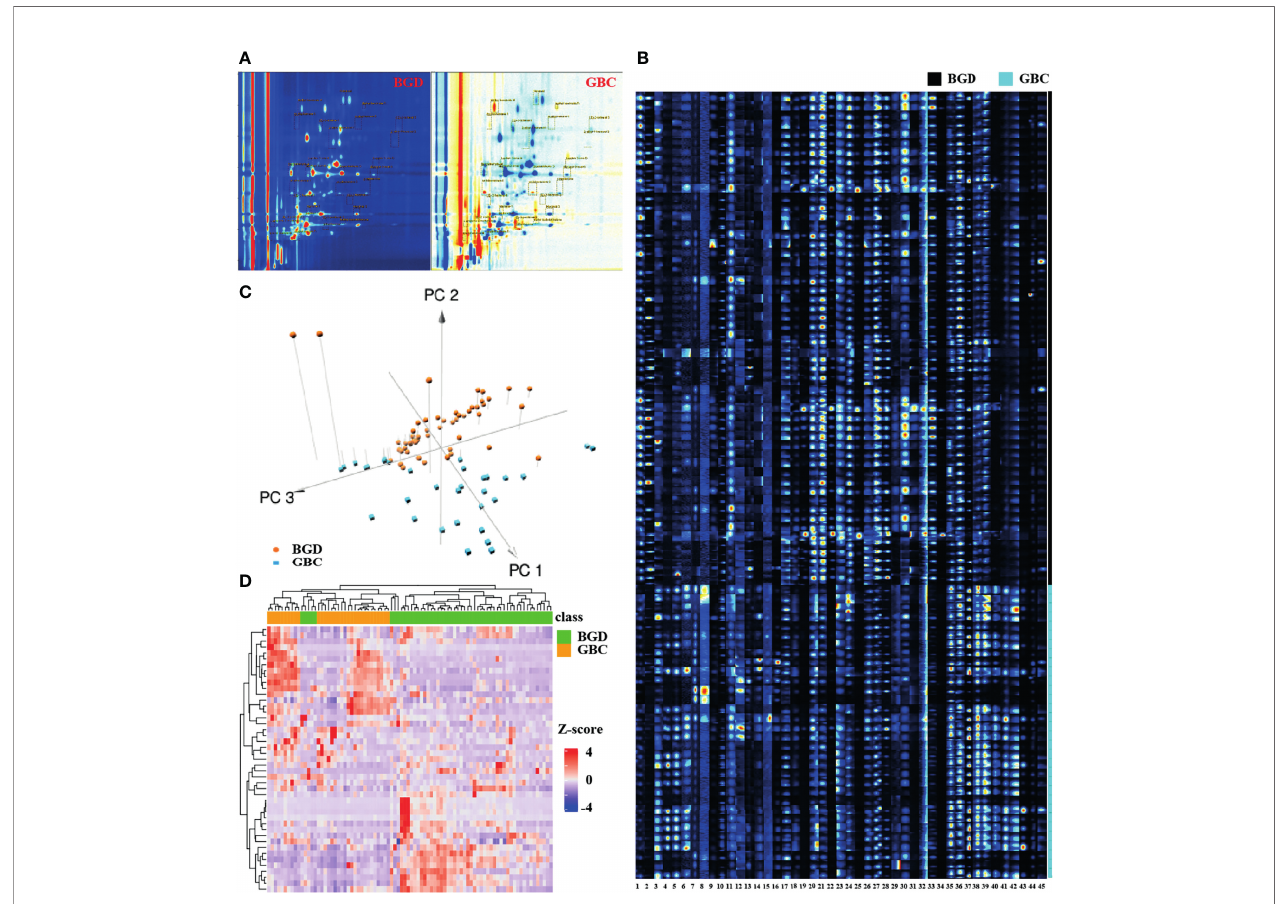
FIGURE 2 | Bile VOCs pro fi le analysis. (A) 2D spectral map for BGD and GBC, and each point represent a signal peak. (B) GC-IMS signals detected in the bile of BGD and GBC patients. (C) A 3-dimensional scatterplot generated from PCA for of VOCs pro fi les in BGD and GBC patients. (D) Heatmap of GC-IMS VOCs pro fi les in BGD and GBC patients. Note: 1. Unknown-1, 2. Unknown-2, 3. Unknown-3, 4. Unknown-4, 5. Unknown-5, 6. Unknown-6, 7. Methyl benzoate-M, 8. Methyl benzoate-D, 9. pentan-1-o1, 10. 2-heptanone, 11. Nonanal, 12. methyl acetate-M, 13. methyl acetate-D, 14. Methyl isobutyl ketone, 15. 1-propene-3-methylthio, 16. 2-Pentanone, 17. Butyl acetate, 18. 1-octen-3-one-M, 19. 1-octen-3-one-D, 20. (E)-hept-2-enal-1, 21. (E)-hept-2-enal-2, 22. (E)-hept-2-enal-3, 23. (E)-2- octenal-1, 24. (E)-2-octenal-2, 25. (E)-2-octenal-3, 26. Hexanal-1, 27. Hexanal-2, 28. Hexanal-3, 29. (E)-2-pentenal-1, 30. (E)-2-pentenal-2, 31. (E)-2-pentenal-3, 32. (E)-2-hexenal-1, 33. (E)-2-hexenal-2, 34. (E)-2-hexenal-3, 35. cyclohexanone-1, 36. cyclohexanone-2, 37. cyclohexanone-3, 38. 2-ethyl-1-hexanol-1, 39. 2-ethyl- 1-hexanol-2, 40. 2-ethyl-1-hexanol-3, 41 Acetophenone-1, 42. Acetophenone-2, 43. Acetophenone-3, 44. Benzaldehy de-M, 45. Benzaldehy